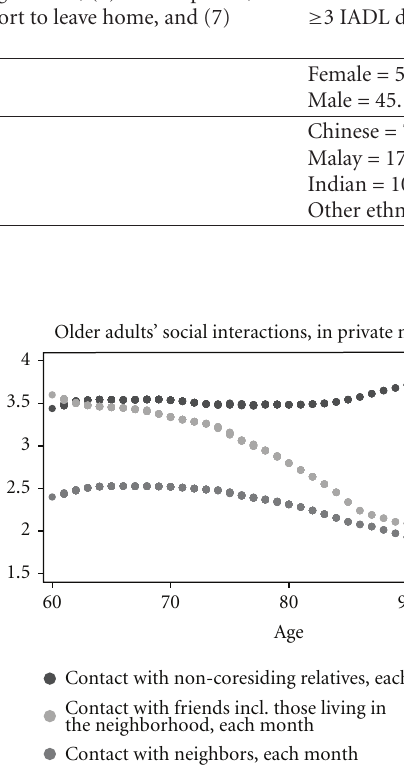
Figure 2: These locally weighted bivariate regressions do not con- trol for